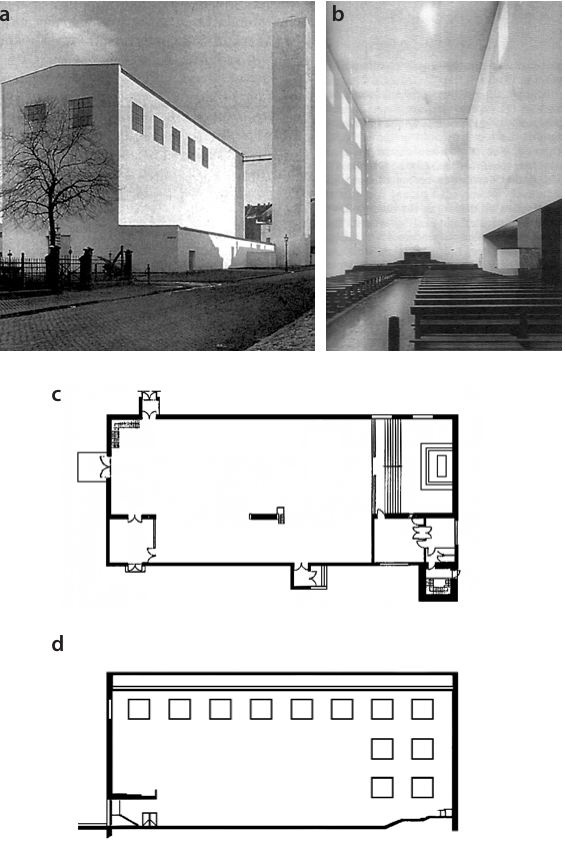
Fig. 1. R. Shwarz, Corpus Christi Church, Aachen, Germany, 1928–1930: a – exterior, b – interior, c – plan, d –